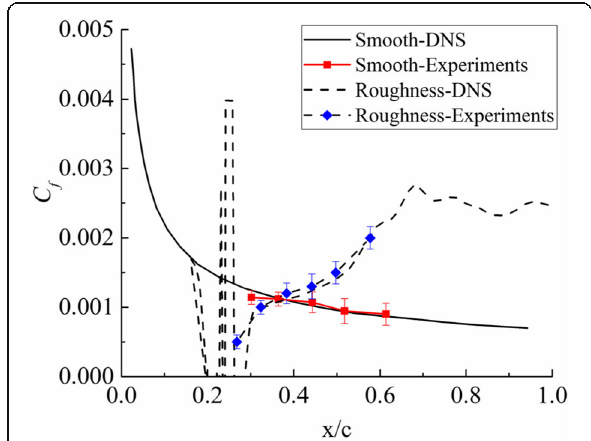
Fig. 14 Comparison between experimental and DNS results of C